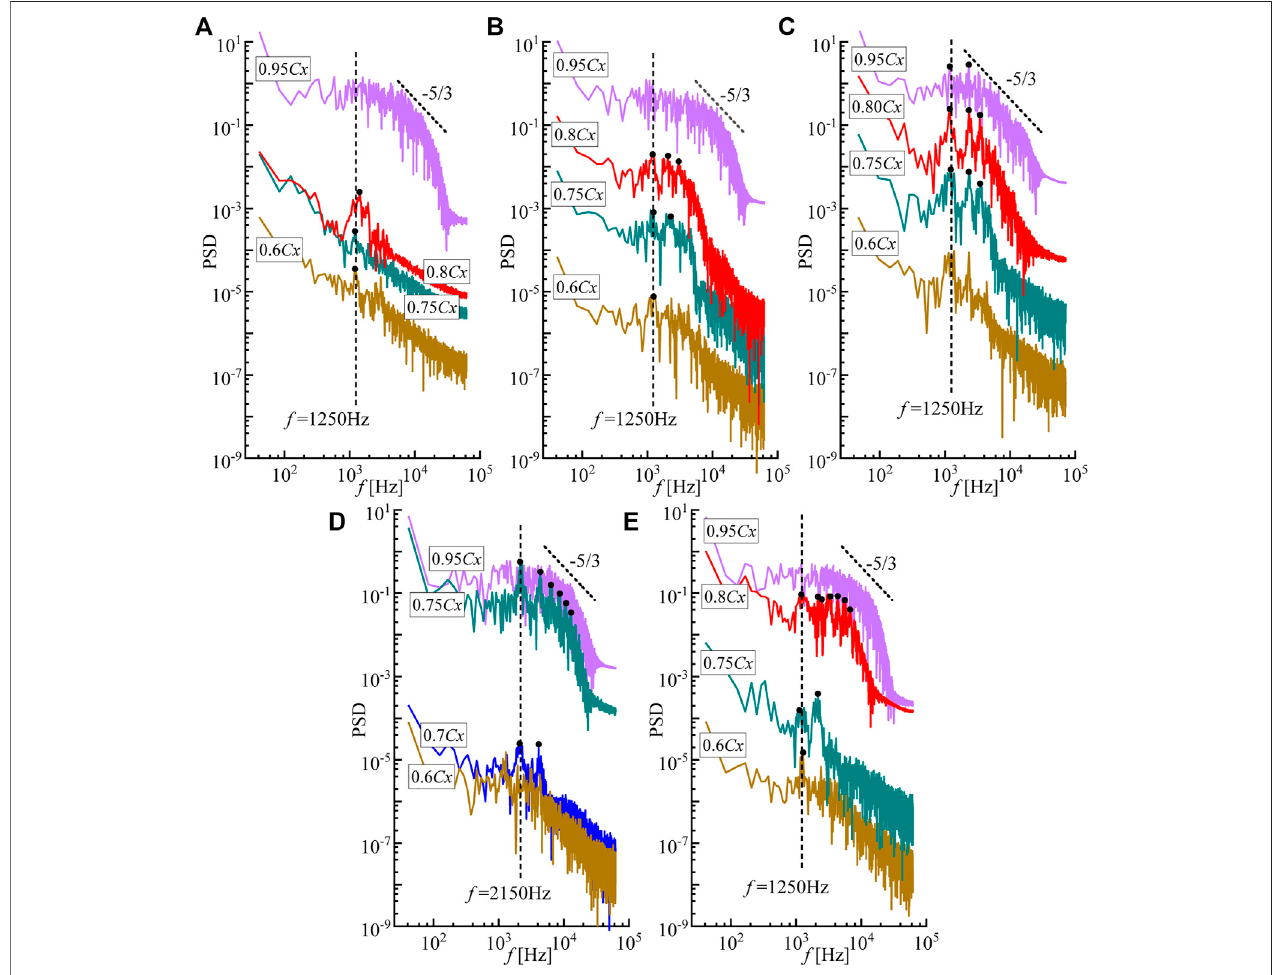
FIGURE 11 | Power spectral of streamwise velocity fl uctuations for all cases at various axial positions: (A) baseline; (B) U-shape; (C) rectangular shape; (D) DC plane; (E) DE plane.